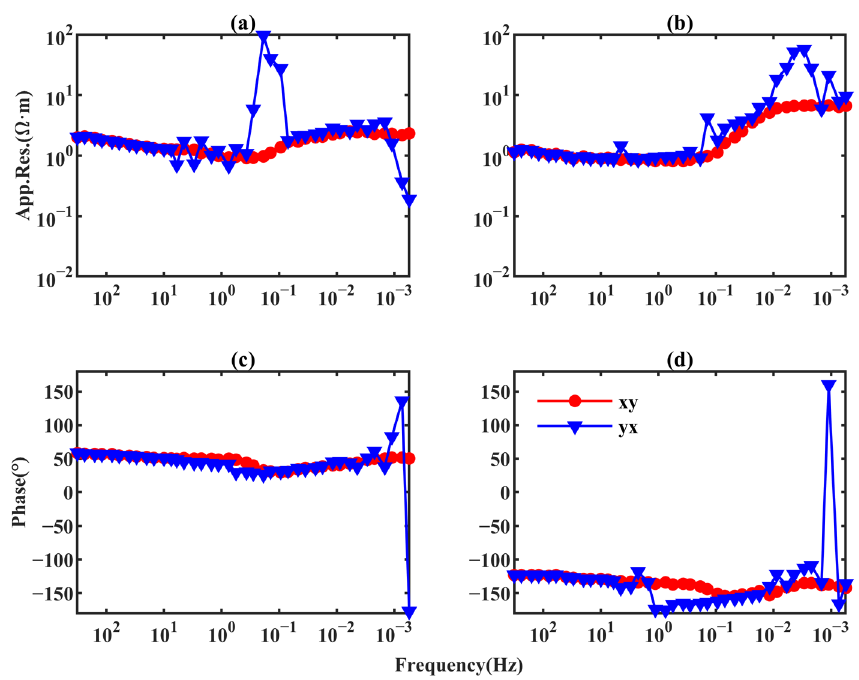
Figure 15. The apparent resistivity and phase of the 12th test dataset. ( a ) ρ xy , ( b ) ρ yx , ( c ) ϕ xy and ( d ) ϕ yx curves.